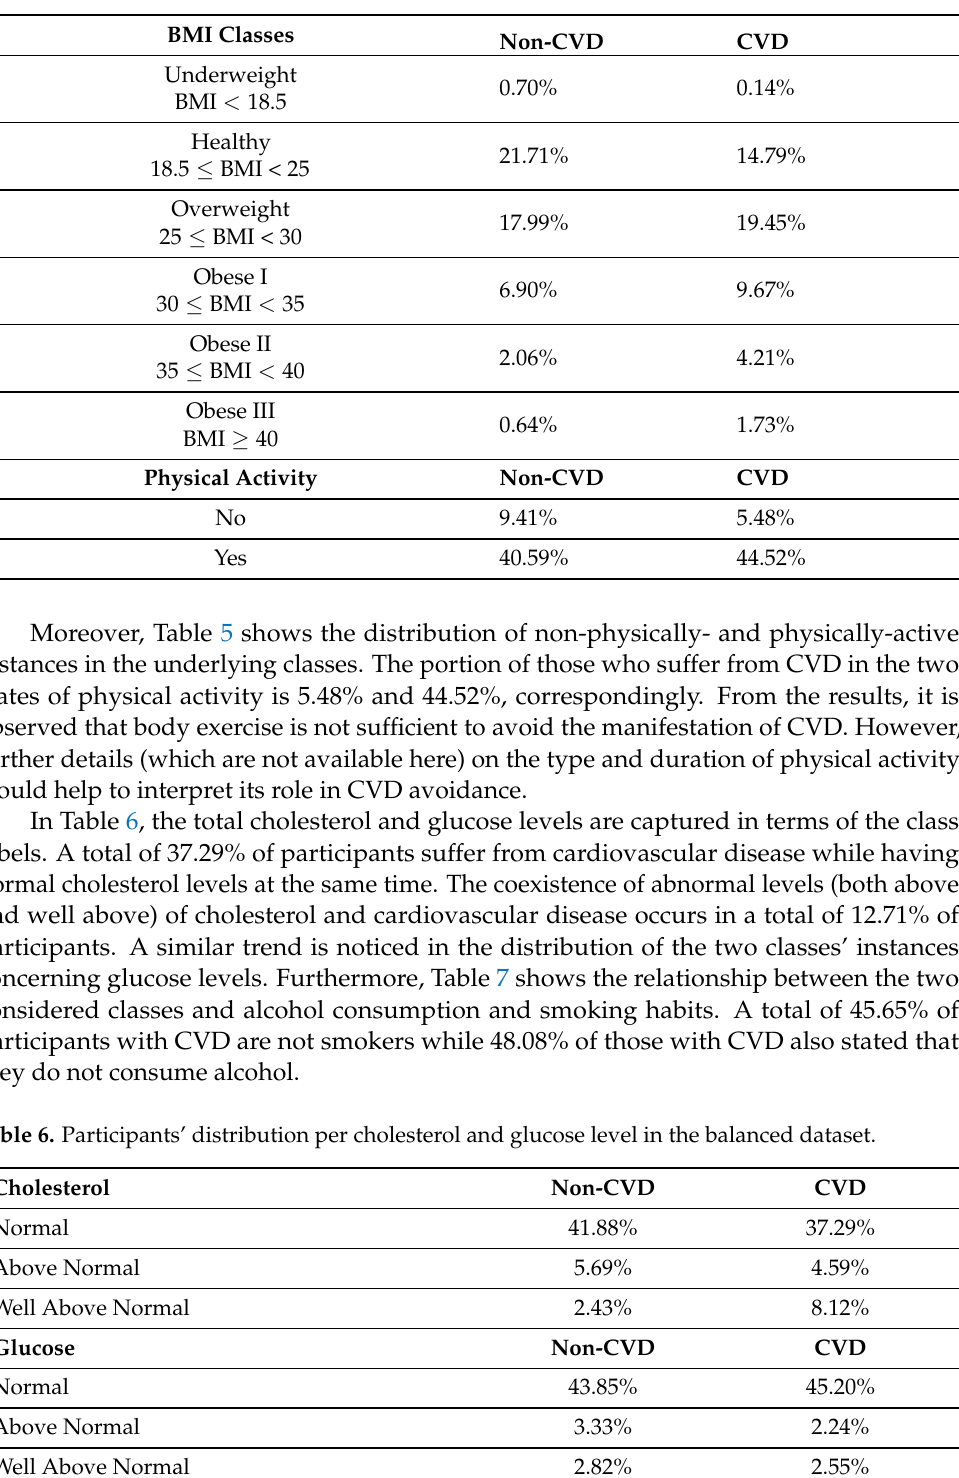
Table 5. Participants’ distribution per BMI class and physical activity in the balanced dataset.